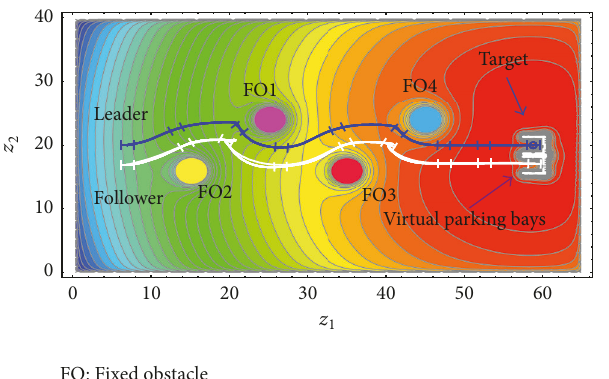
Figure 6: The evolution of C-ITS trajectories and the contour plot in the presence of obstacles in Scenario 1.